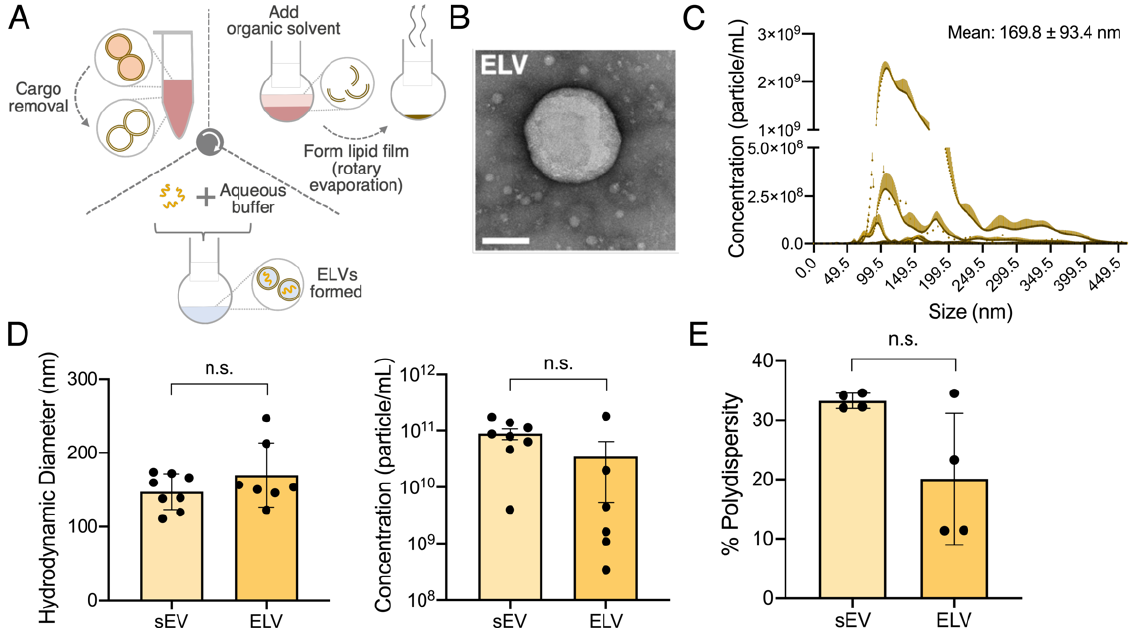
Figure 2. Synthesis and characterization of sEV-derived sEV-like vesicles (ELVs) using a modified thin-film-hydration (TFH) method. ( A ) Workflow of ELV synthesis from CPC-sEVs by depleting sEV cargo, forming a lipid film and rehydrating with customized microRNA (miRNA). ( B ) Transmission-electron microscopy image of an engineered ELV. Scale bar = 100 nm. ( C ) Concentration-size profile of an ELV with NTA. n = 10. ( D ) Comparison of ELV and sEV size and concentration. ( E ) Comparison of percentage poly-dispersity of ELVs and sEVs. n = 4–8 represent biological replicates. Mean ± SEM. Significance was tested with two-way, Student’s paired t- test. n .s. = not significant.